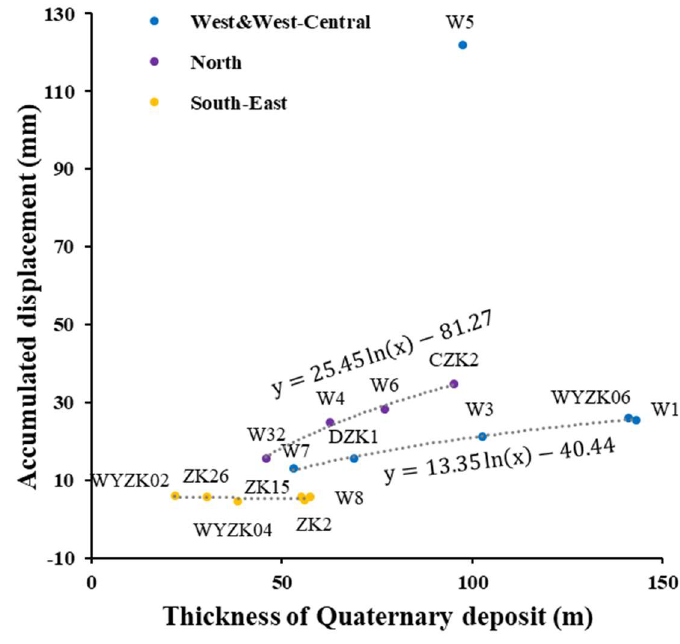
Figure 9. Logarithmic regression between the accumulated displacement and thickness of the Quaternary deposit.